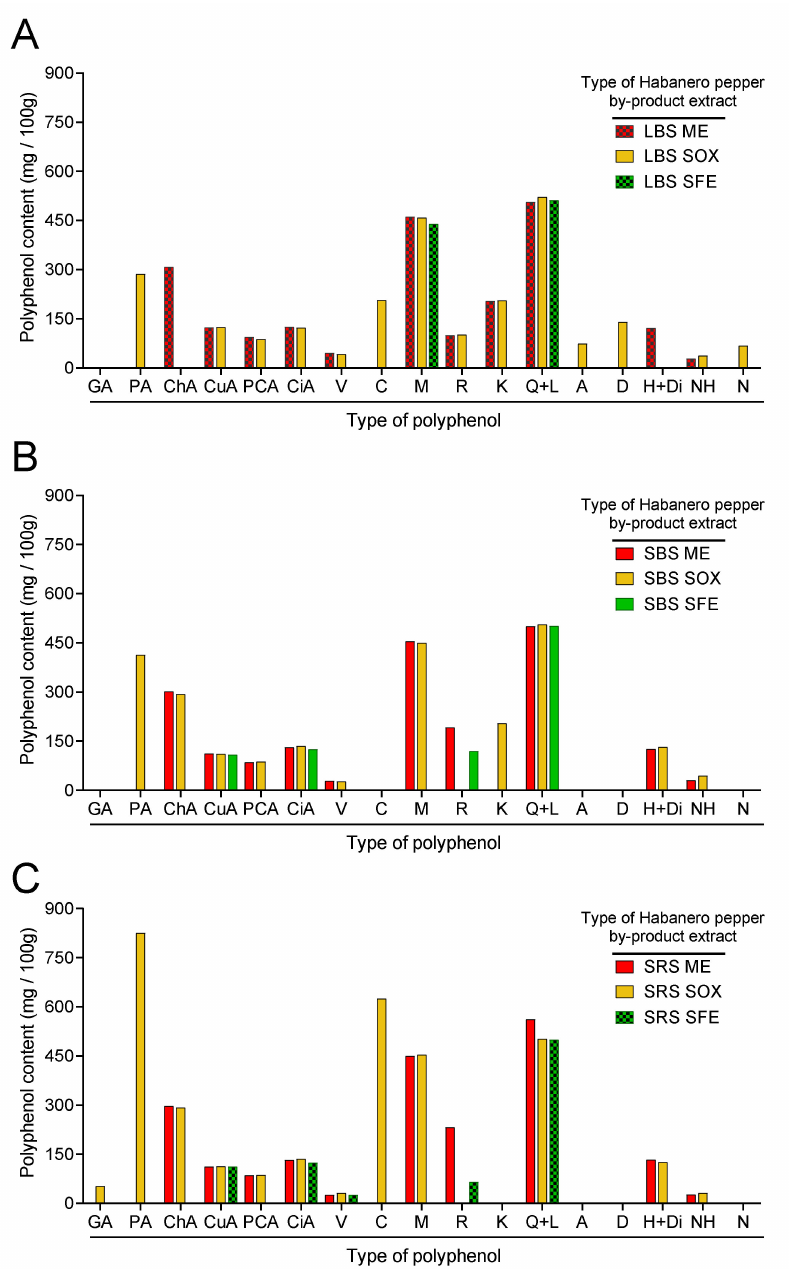
Figure 3. Comparison of the polyphenol content of C. chinense by-product extracts obtained by ME, SOX and SFE of leaves of plants grown in black soil ( A ), stems of plants grown in black soil ( B ), stems of plants grown in red soil ( C ) of Yucat á n, M é xico. GA: gallic acid; PA: protocatechuic acid; Cha: chlorogenic acid; CuA: coumaric acid; PCA: p -coumaric acid; CiA: cinnamic acid; V: vanillin; C: catechin; M: myricetin; R: rutin; K: kaempferol; Q + L: quercetin + luteolin; A: apigenin; D: diosmetin; H + Di: hesperidin + diosmin; NH: neohesperidin; N: naringenin. LBS: leaves from plants grow in black soil; SBS: stems from plants grow in black soil; SRS: stems from plants grow in red soil. ME: maceration extraction with methanol; SOX: Soxhlet extraction with ethanol; SFE: supercritical fluids extraction with CO 2 + ethanol (5%). Bars with white dots are extracts with anti-inflammatory